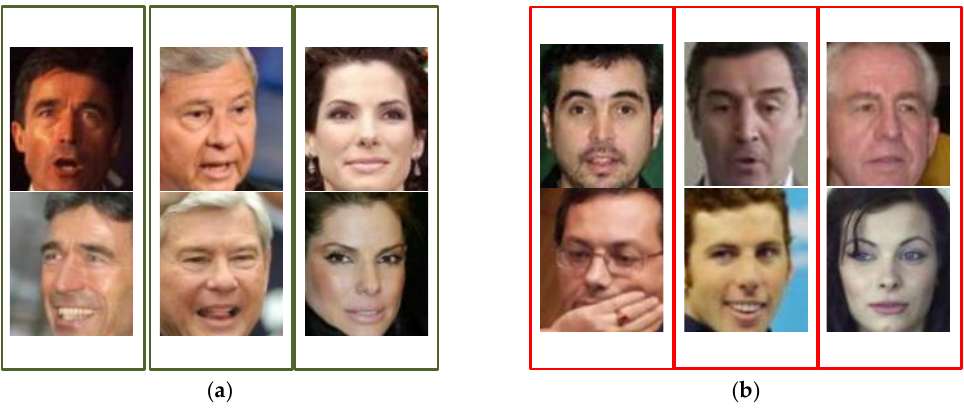
Figure 8. The Labeled Faces in the Wild (LFW) test set face verification pair. ( a ) Face verification for the same objects. ( b ) Face verification for different objects.